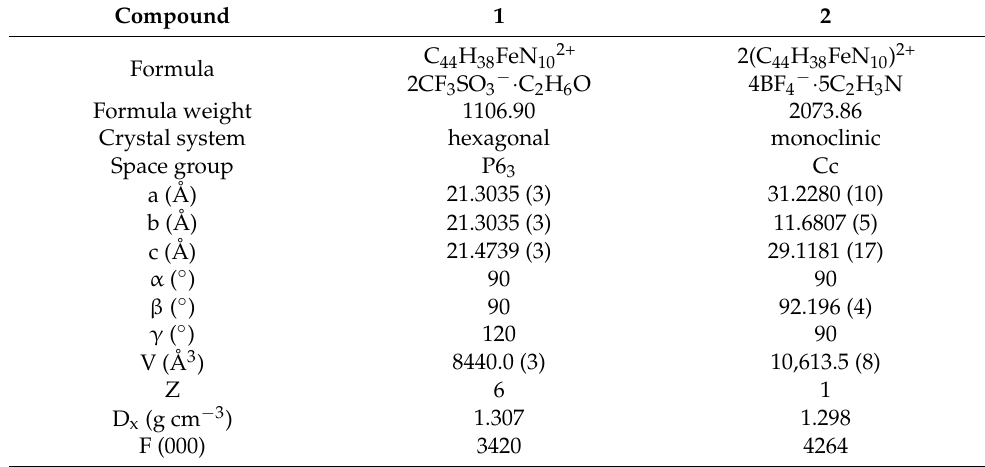
Table 1. Crystal data, data collection and structure